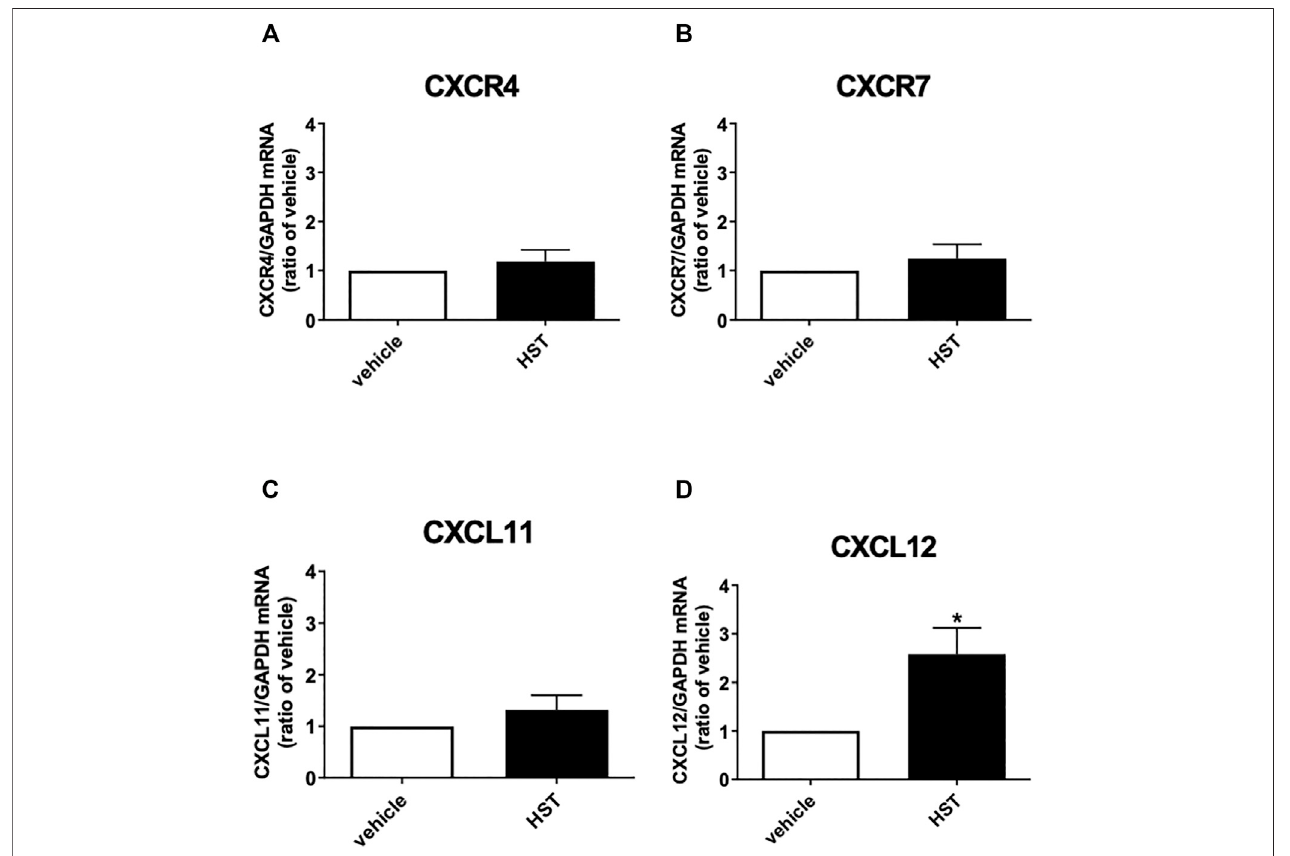
FIGURE 2 | Effect of Hangeshashinto (HST) on the mRNA expression of CXCR4, CXCR7, CXCL11, or CXCL12 in human oral keratinocytes (HOKs). HOKs were scratched and treated with vehicle or HST for 48 h mRNA expression was determined by RT-qPCR. (A) CXCR4 ( n (cid:2) 5), (B) CXCR7 ( n (cid:2) 6), (C) CXCL11 ( n (cid:2) 5), or (D) CXCL12 ( n (cid:2) 6). Data are presented as the mean ± SEM (bars). * indicates p < 0.05, compared with vehicle; unpaired t